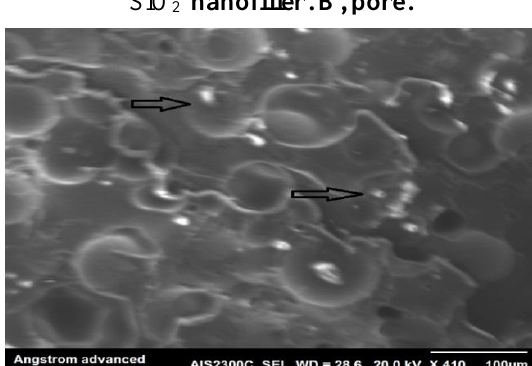
Figure 5: SEM of the fractured impact surface re-inforced by 2% SiO Arrows show